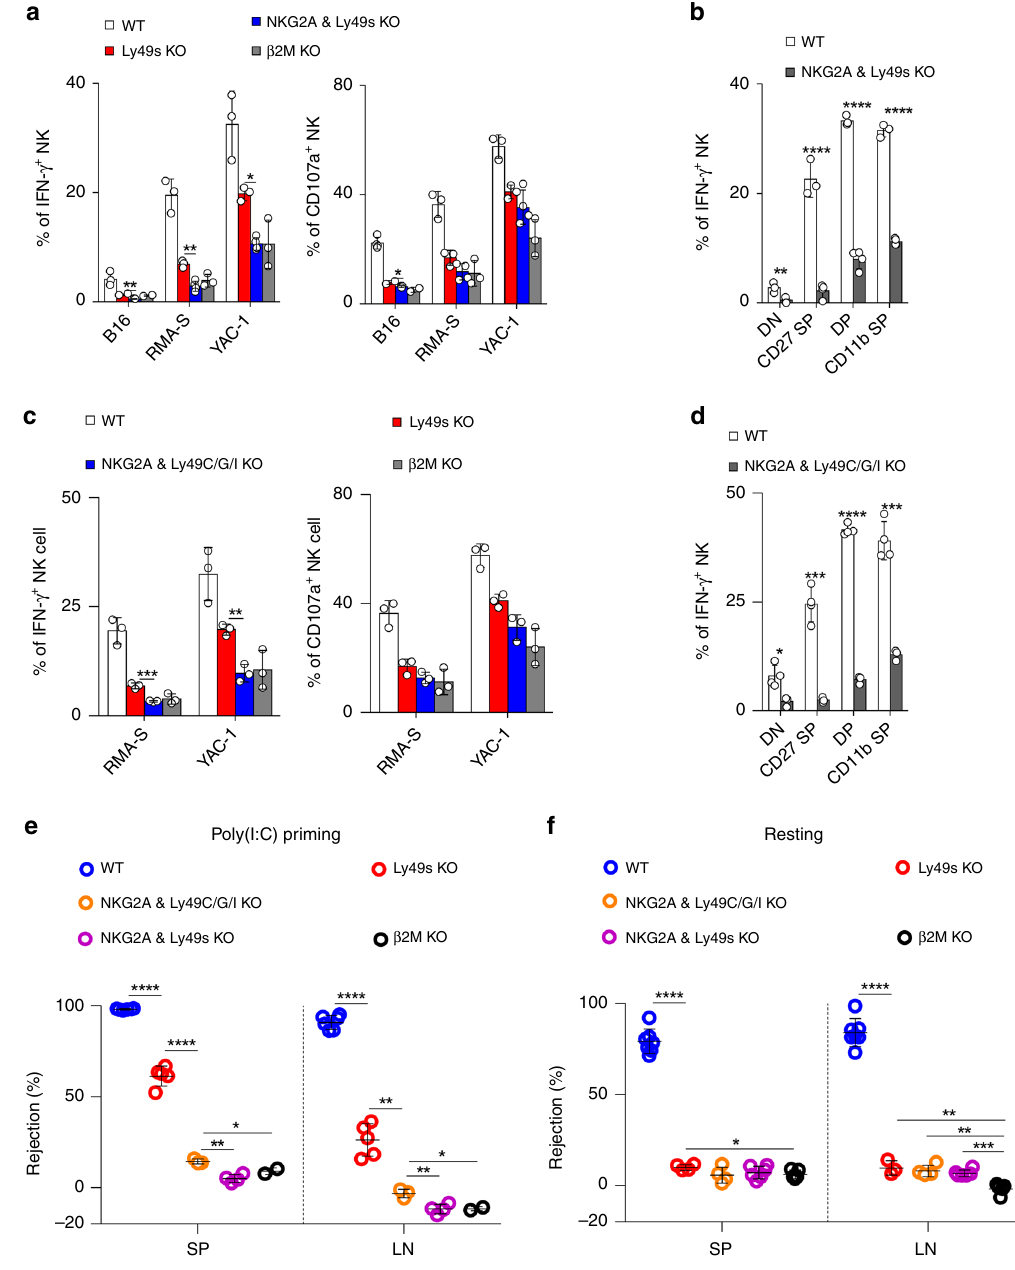
Fig. 7 The combined de fi ciency of inhibitory Ly49-family receptors and NKG2A severely impairs NK-cell education. a Poly(I:C)-primed splenocytes from the indicated mice were stimulated with tumour target cells. The percentages of IFN- γ + or CD107a + gated CD3 − NKp46 + NK cells were analysed. b Poly(I: C)-primed splenocytes from indicated mice were stimulated by YAC-1 tumour targets. Frequency of IFN- γ + of four NK-cell subsets (gated CD3 − NKp46 + ), including DN (CD27 − CD11b − ), CD27 SP (CD27 + CD11b − ), DP (CD27 + CD11b + ) and CD11b SP (CD27 − CD11b + ) were analysed. c Similar to ( a ). d Similar to ( b ). e In vivo rejection of β 2M-de fi cient splenocytes (similar to Fig. 3a). f In vivo rejection of β 2M-de fi cient splenocytes (similar to Fig. 3d). Each symbol represents an individual mouse. Data shown represent two ( e , f ) or at least three ( a – d ) independent experiments. Mean± SD is shown. * p < 0.05, ** p < 0.01, *** p < 0.001 and **** p < 0.0001. Unpaired Student ’ s t -tests (two-tailed) was used to calculate these values. Source data are provided as a